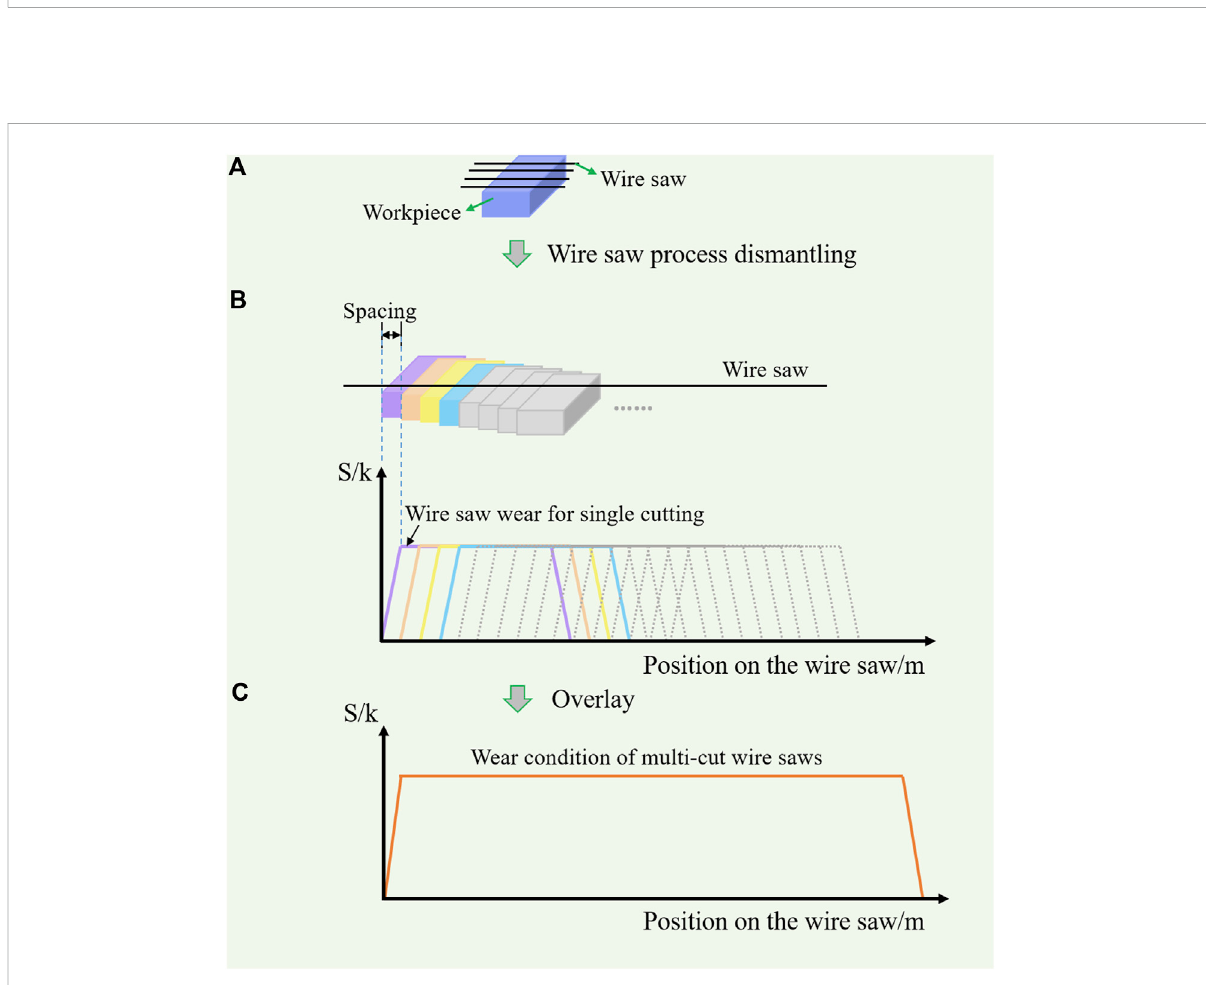
FIGURE 6 Wire saw wear overlay from single wafer to multi-wafer. (A) Schematic diagram of multi-wire sawing, (B) Unroll the wire saw of the wire web to achieve the wear on the wire saw for cutting each wafer, (C) Overlay the wear on the wire saw generated by each wafer.